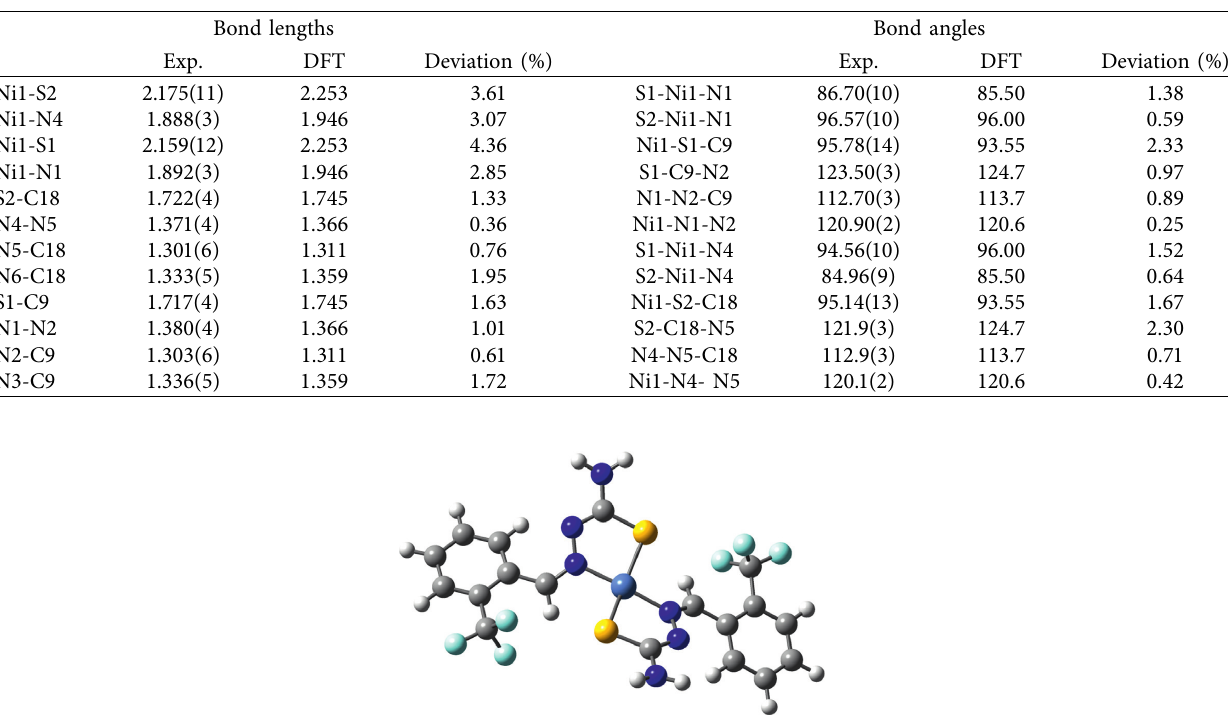
Table 2: The experimental and optimized bond lengths (˚A) and angles ( ° ) for NiL